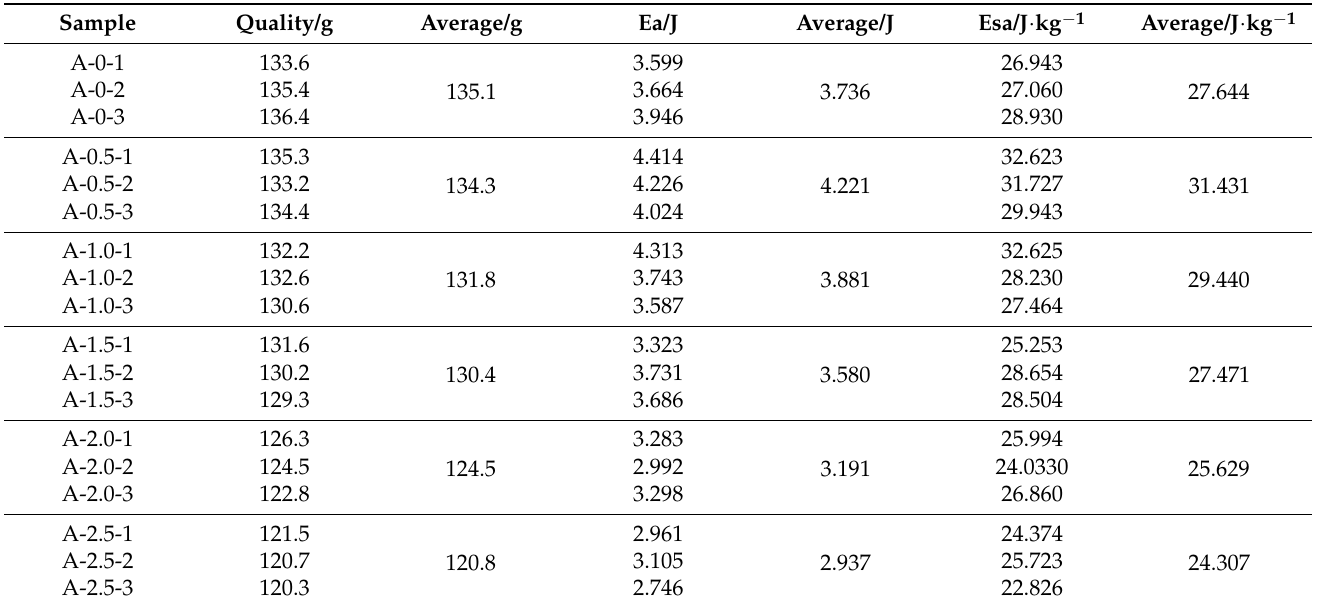
Table 5. Mass and energy absorption index of different concave hexagonal unit